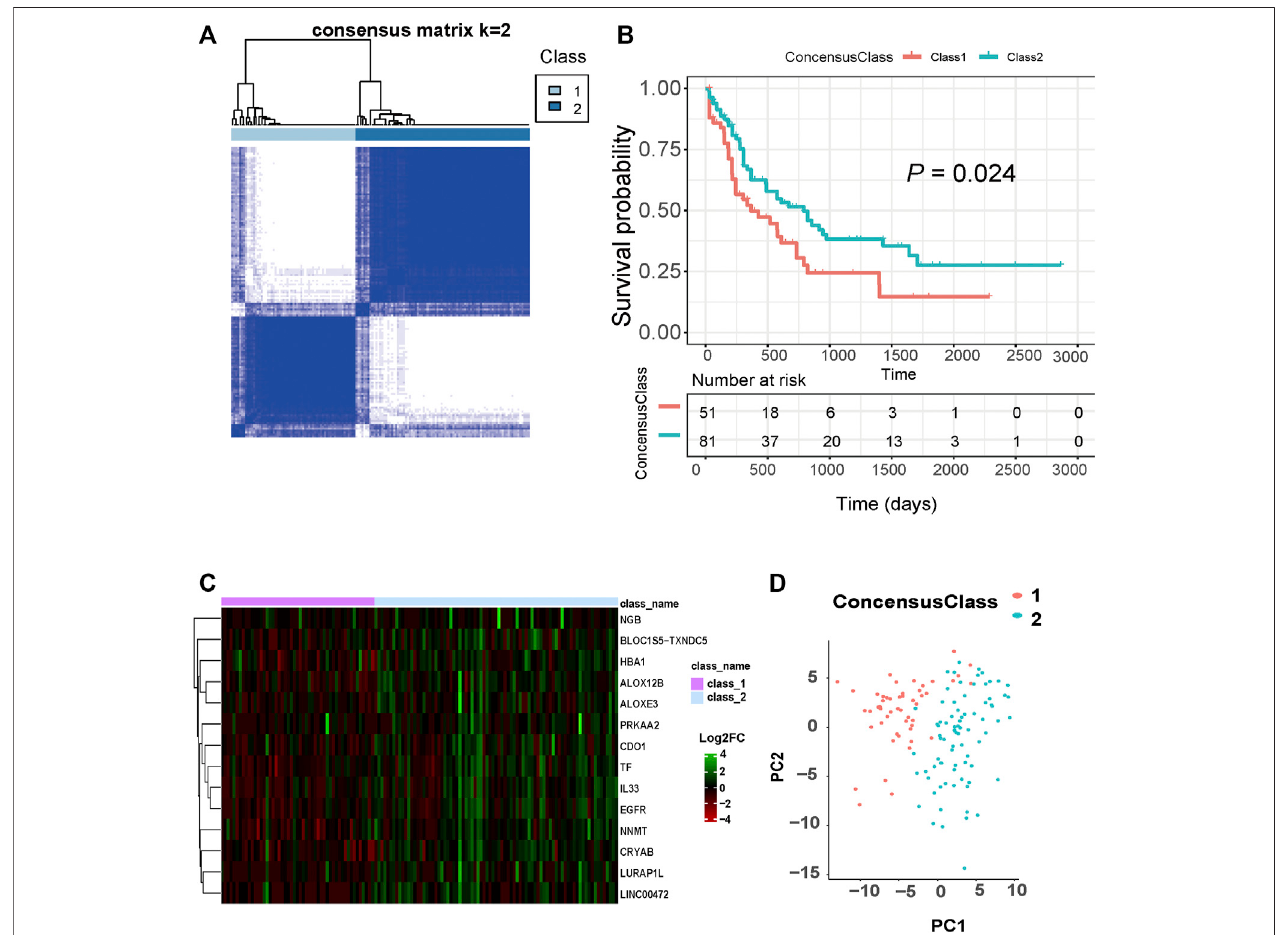
FIGURE 2 | Classi fi cation of AML based on ferroptosis-related genes. (A) The optimal AML classi fi cation according to consensus matrix (k (cid:1) 2). (B) KM survival analysis for the two subtypes. (C) Heat maps of these signi fi cantly differential ferroptosis-related genes between two subtypes. (D) PCA analysis ofsample distributions based on ferroptosis-affected